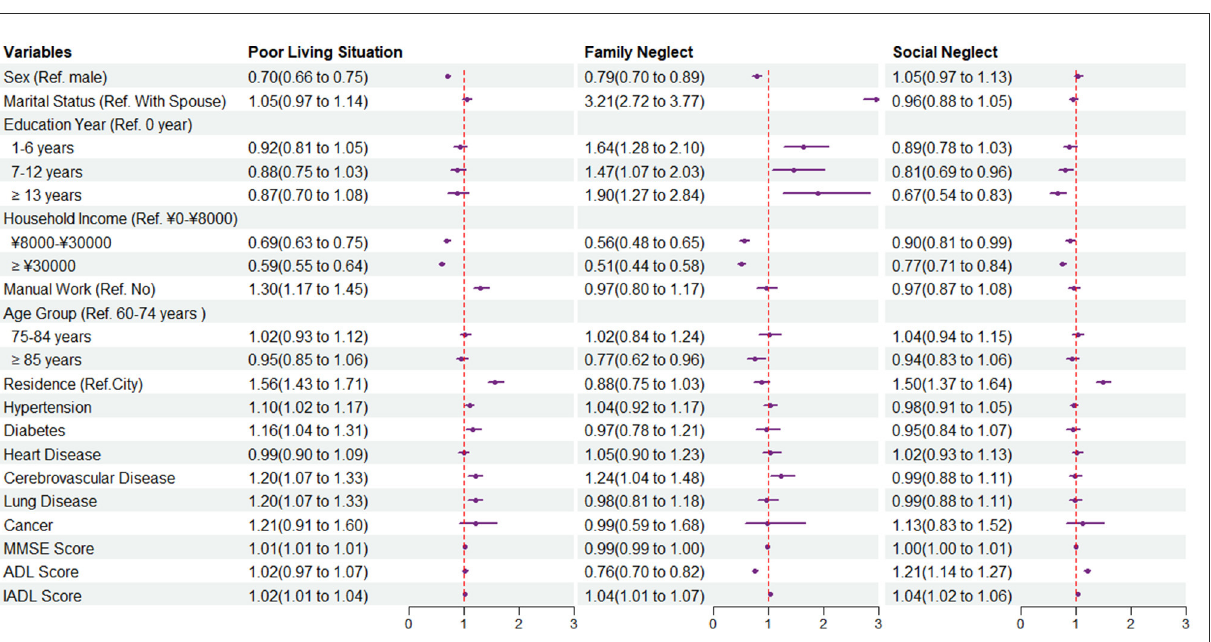
and require intimate support from their households.